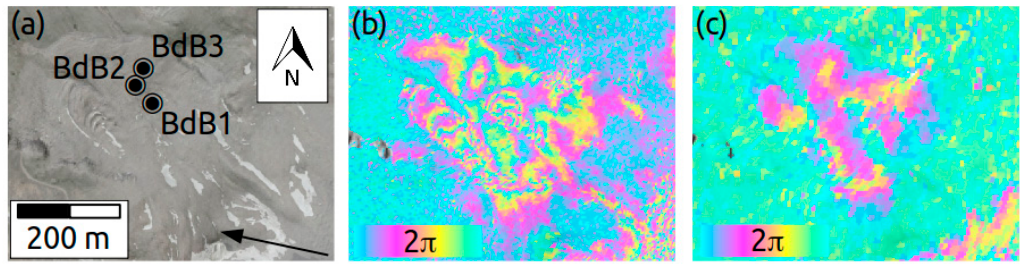
Figure 6. ( a ) Becs-de-Besson rock glacier (Val de Réchy, Switzerland) with positions of the two permanent GNSS stations used for validation (BdB1 and BdB2) and of the Sentinel-1 InSAR time series of Figure 7 (BdB3), image data are from Google, DigitalGlobe; ( b ) TerraSAR-X interferogram from 01.10.2012 to 12.10.2012, 2 π ⇔ 1.6 cm; ( c ) Sentinel-1 interferogram from 07.09.2018 to 13.09.2018, 2 π ⇔ 2.8 cm. The black arrow indicates the satellite line-of-sight.